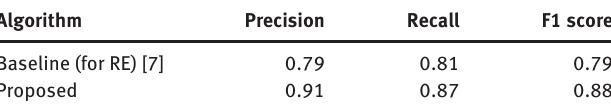
Table 3: Precision, Recall, and F1 Score Comparison of Baselines and Our Proposed Method for RE. Algorithm